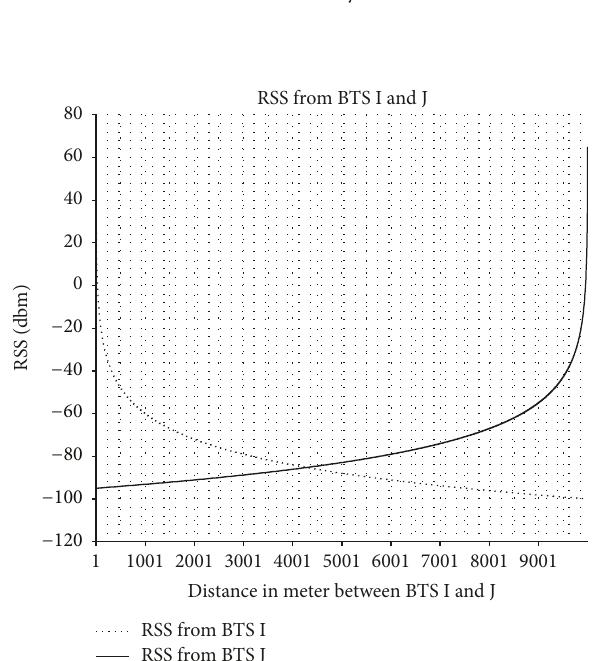
Figure 1: GSM system.